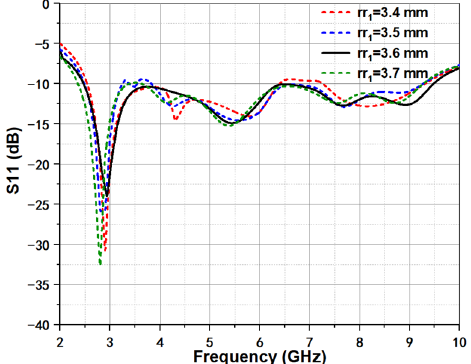
rr rr of spiral curve. of spiral curve. rr of spiral curve.